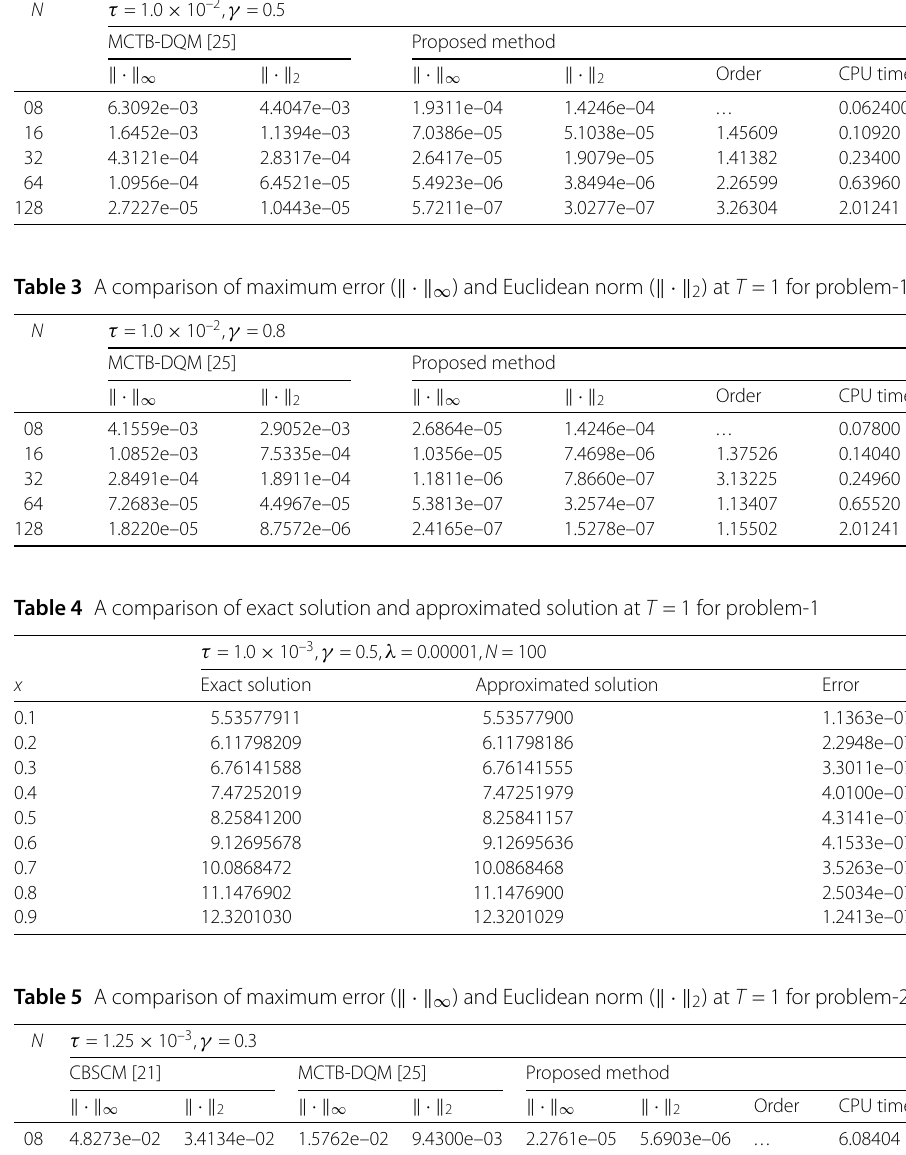
Table 2 A comparison of maximum error ( (cid:10) · (cid:10) ∞ ) and Euclidean norm ( (cid:10) · (cid:10) 2 ) at T = 1 for problem-1 N